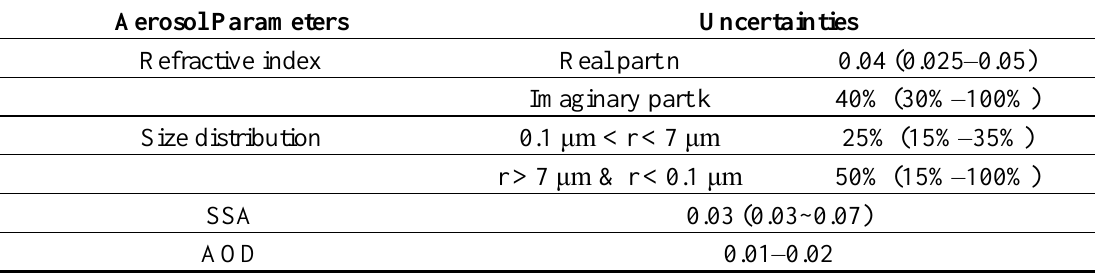
Table 2. Uncertainties of the complex refractive index (real and imaginary part), size distribution, SSA, and AOD [54] *